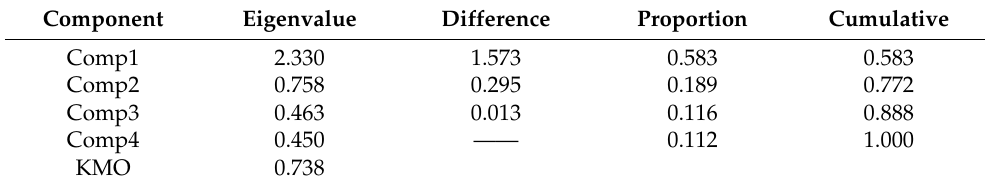
Table 2. Statistics of principal components.